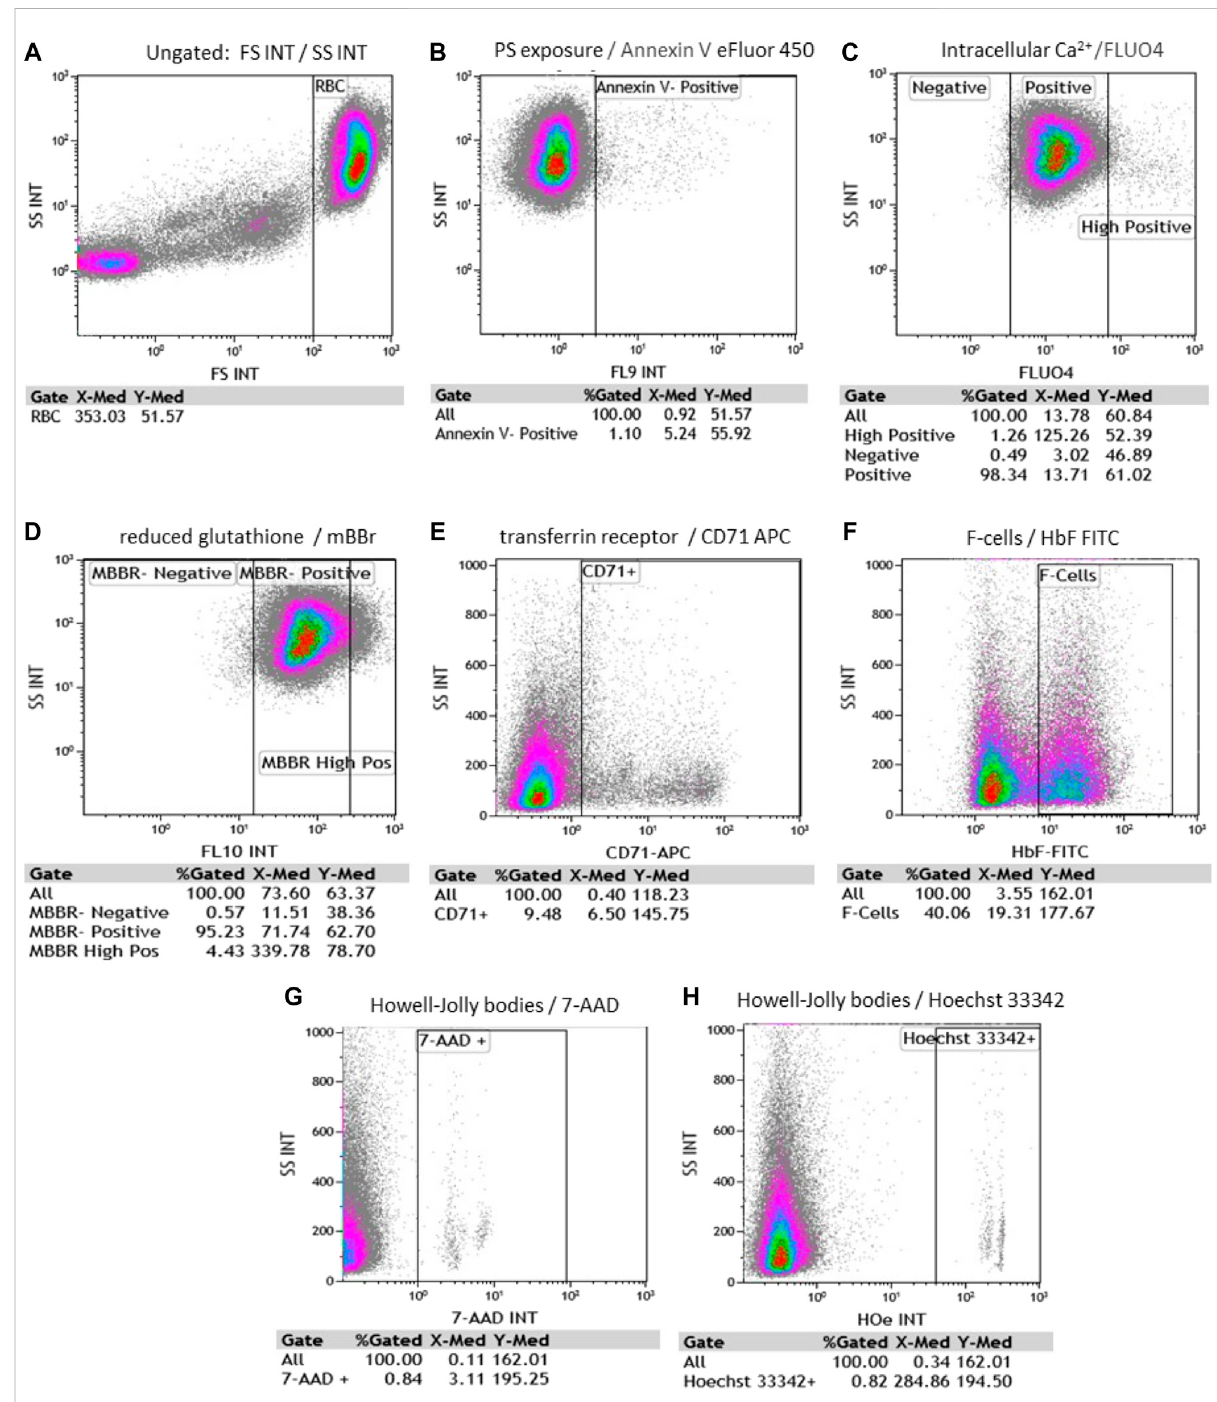
FIGURE 3 Representative fl ow cytometry scatter plots and gating strategy for RBC. Each evaluates % gated cells and median fl uorescence intensity (MFI). (A) RBC side and forward scattering of unstained cells (SS and FS, accordingly); (B) Annexin V-positive RBC; (C) fl uo-4 positive and fl uo-4 high- positive RBC; (D) MBBR-positive and MBBR high-positive RBC; (E) CD71 positive RBC; (F) F- RBC (F-cells) positive fraction (G) 7-AAD (7-amino- actinomycin D) positive RBC and (H) Hoechst 33342 positive RBC. [ (B – H) plots were all gated on